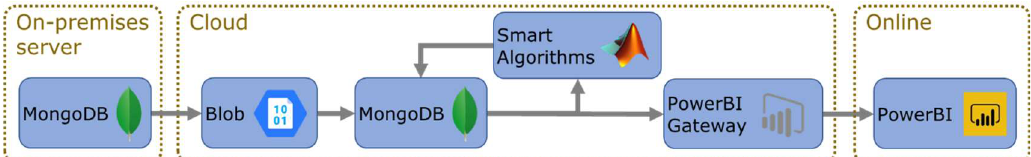
Figure 3. V2G cloud architecture diagram.